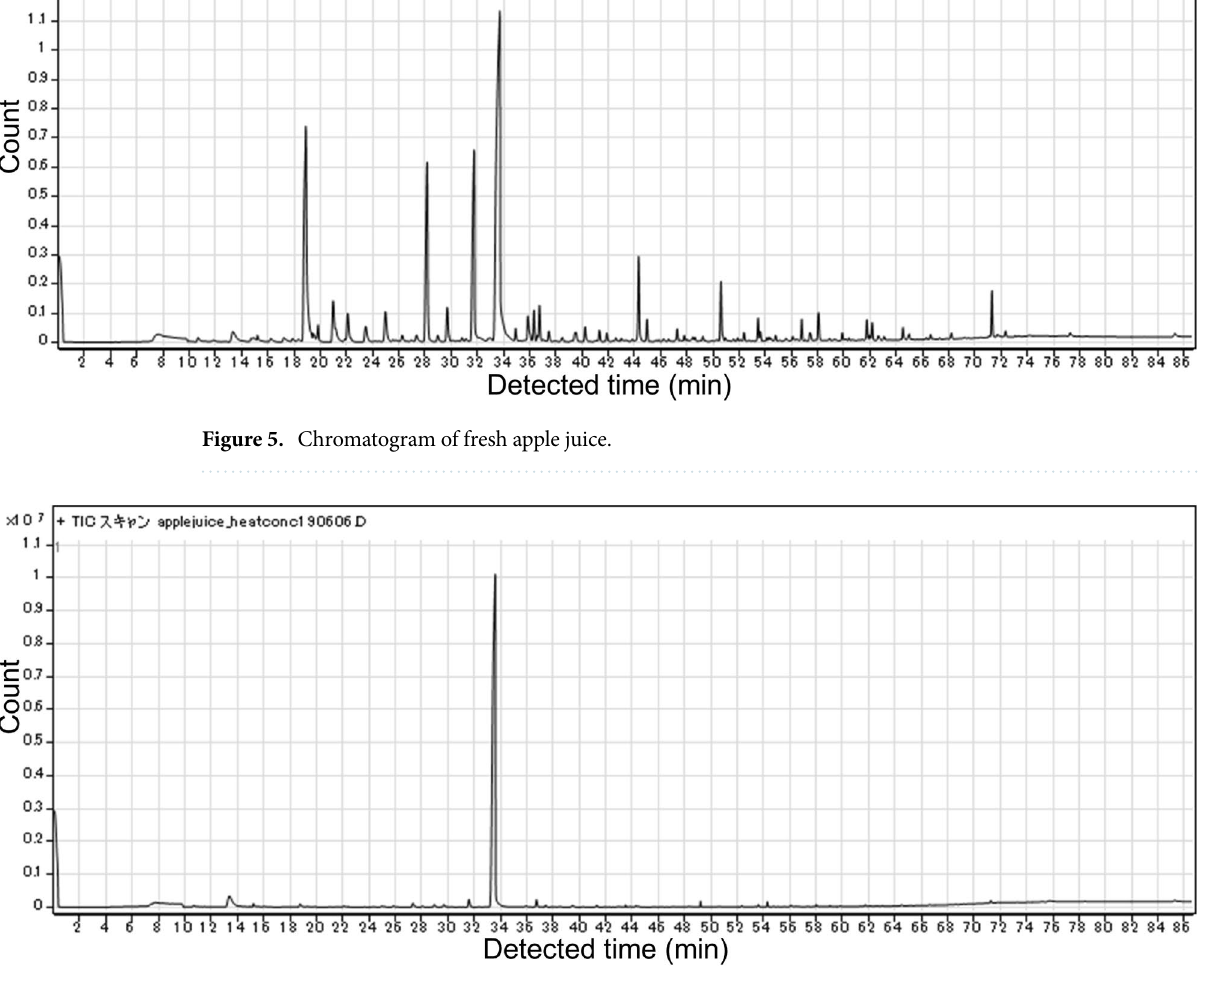
Figure 6. Chromatogram of apple juice concentrated by heating.